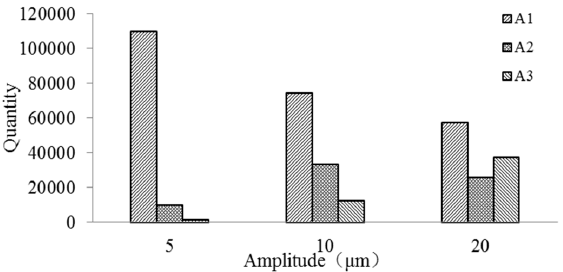
Figure 14. The quantity of debris distribution.